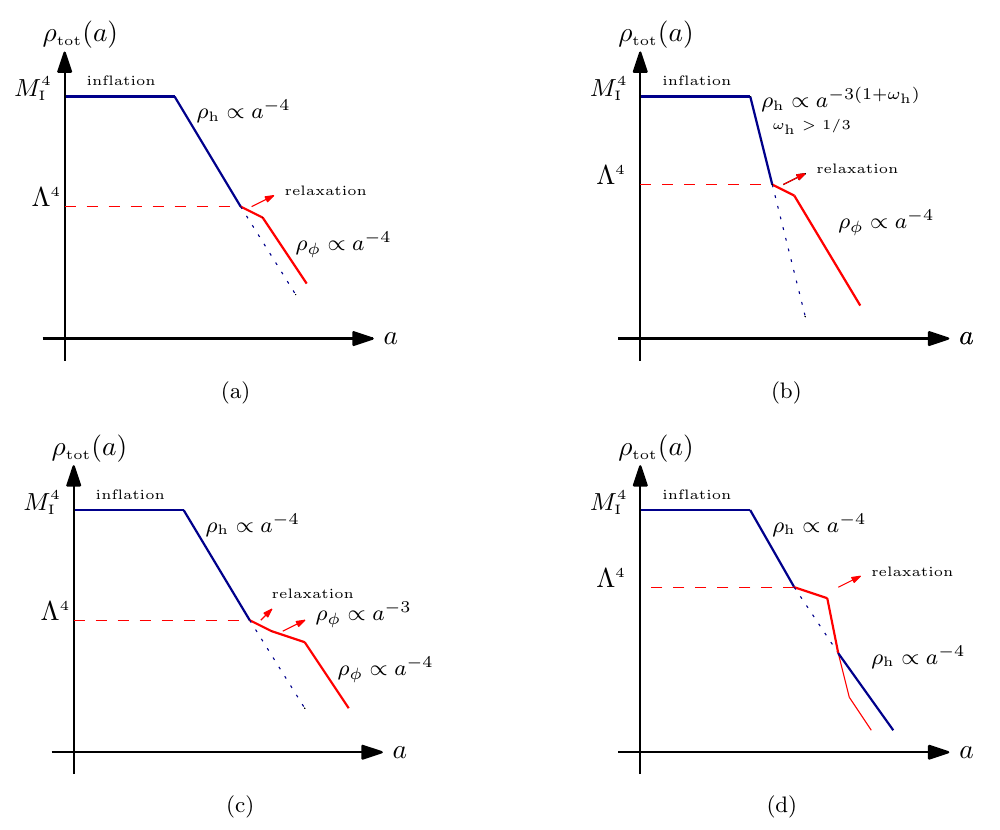
Figure 37 . Sketch of the energy density of the universe as a function of the scale factor for cases where relaxation happens after in(cid:13)ation when the energy density is dominated by the relaxion (cid:12)eld, i.e. H (cid:3) 2 = ( p 3 M Pl ). (a): hidden sector red-shifts as radiation, which makes this scenario very (cid:24) constrained by dark radiation bounds; (b): hidden sector red-shifts faster than radiation ! h > 1 = 3 (as a kination-like period); (c): there is a period of matter domination after relaxation. (d): hidden sector red-shifts as radiation and at the end of relaxation ! (cid:30) > 1 = 3 (kination-like). At late times the hidden sector decays into the Standard Model particles.